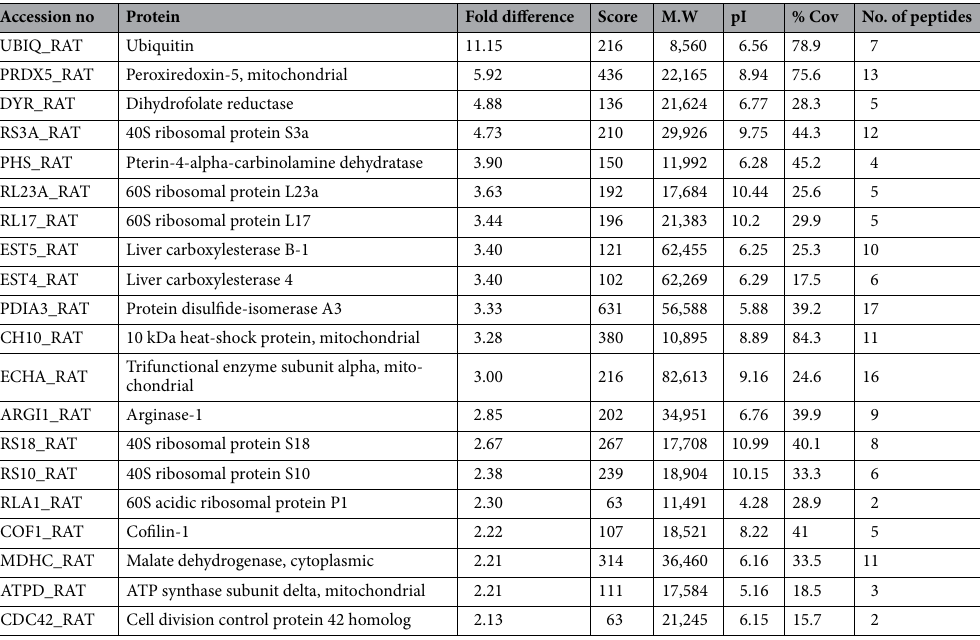
Table 2. Top-20 most downregulated hepatic proteins in the HFLac group vs. the HF